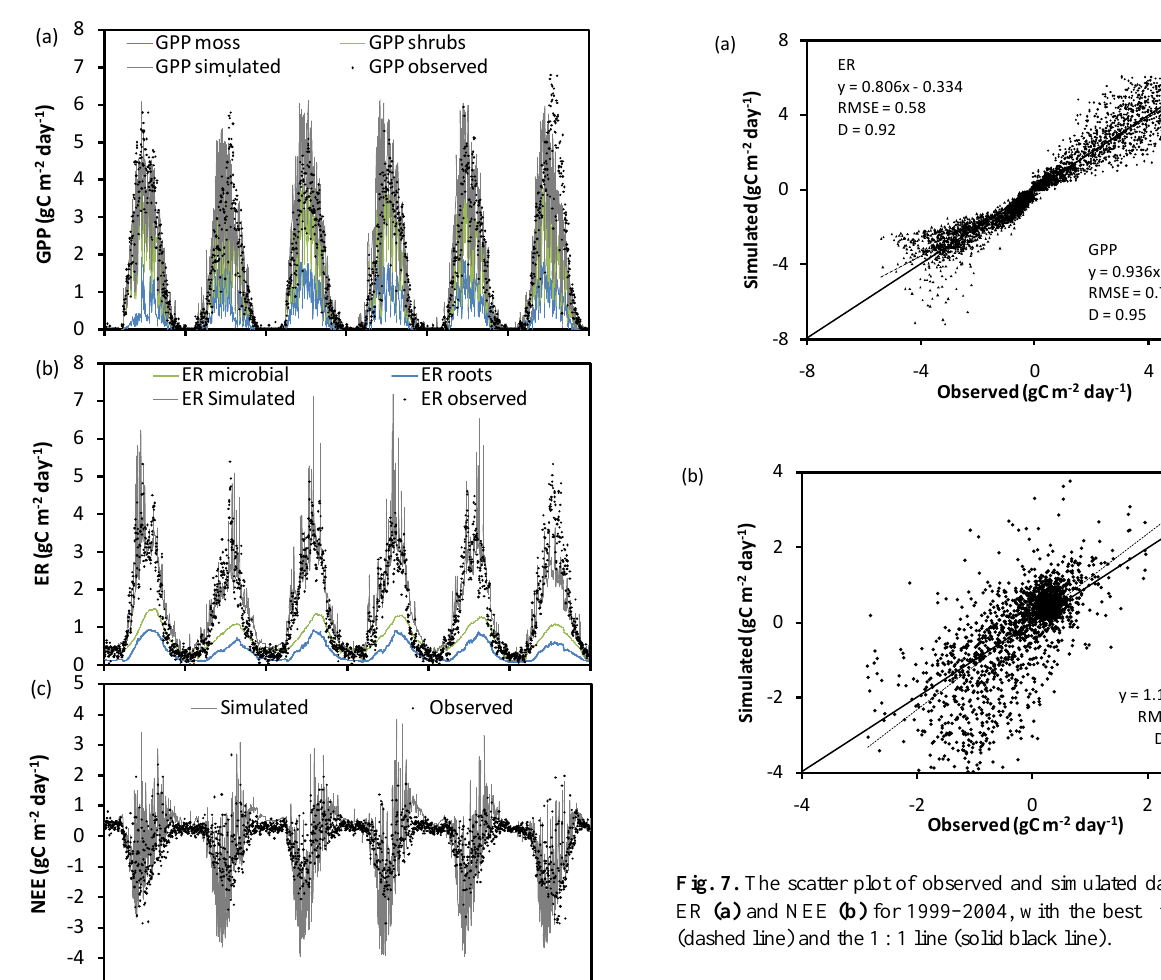
Figure 6. Time series of daily observed average (symbols) and daily simulated (line) GPP and Figure 7. The scatter plot of observed and simulated daily GPP and ER (a) and NEE (b) for 1999 - components (a), ER and its components (b), and NEE (c) for 1999 – 2004. 2004, with the best fit relationship (dashed line) and the 1:1 line (solid black line).